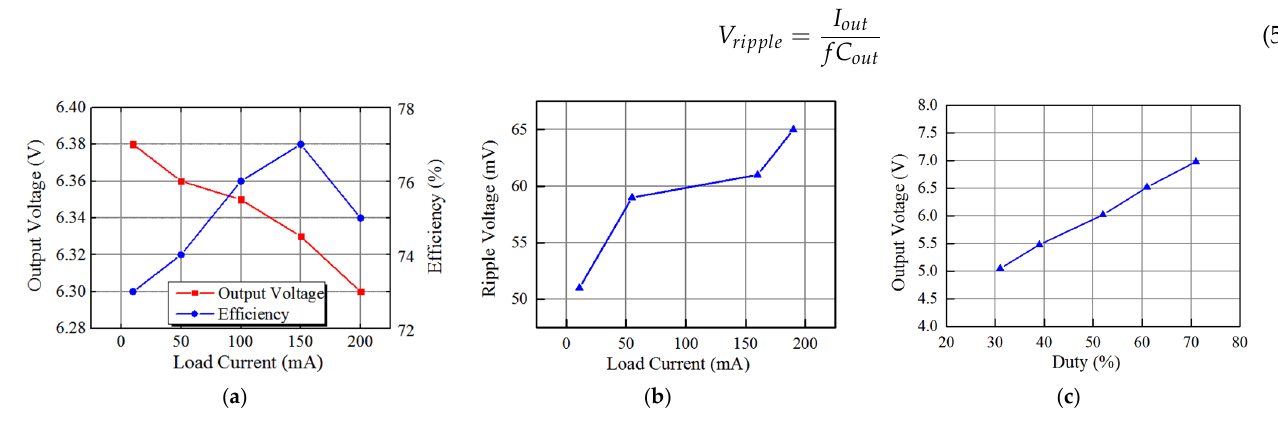
Figure 9. Test results: ( a ) output voltage and power efficiency with variation of the load current; ( b ) ripple voltage with variation of the load current; ( c ) output voltage versus duty.